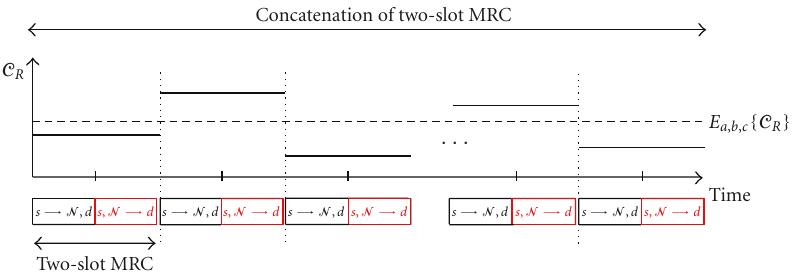
Figure 2: Ergodic capacity: concatenation in time of half-duplex multiple relay